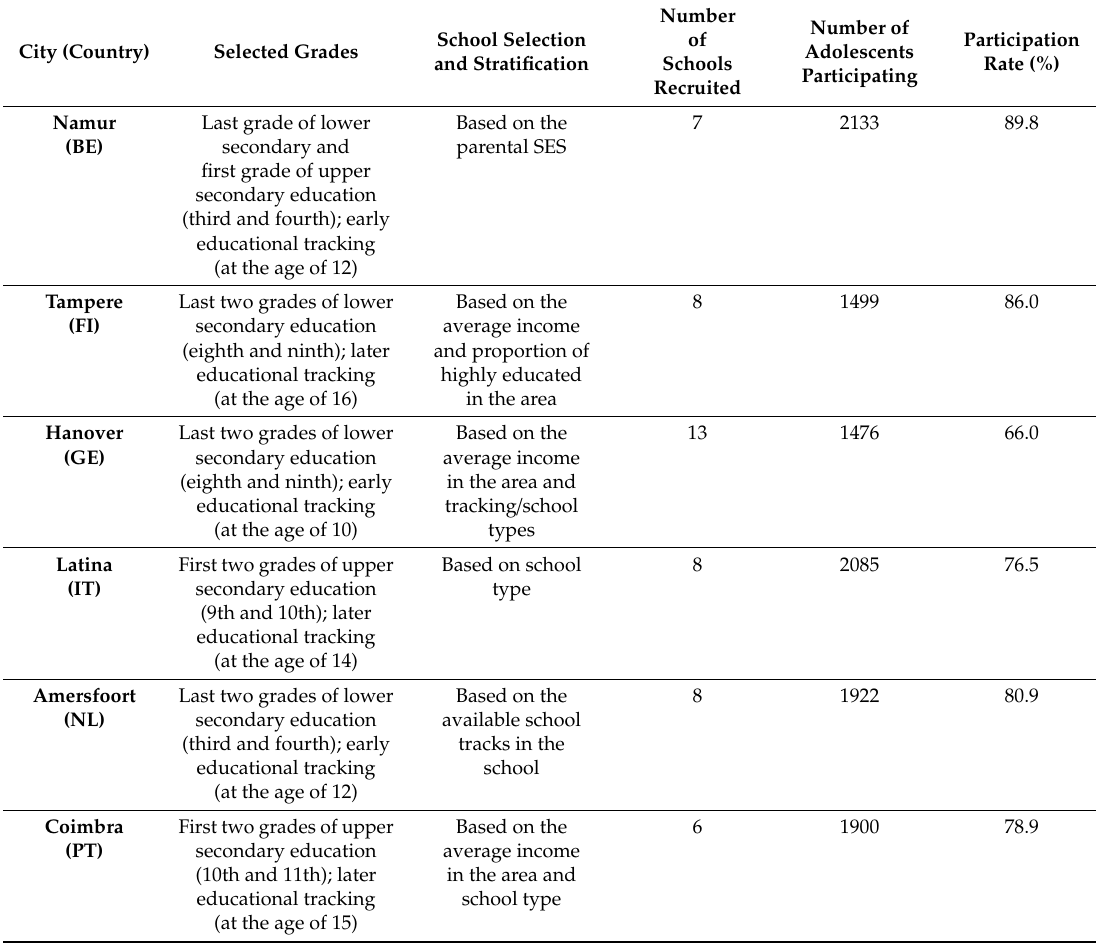
Table A2. Selected grades, school selection and stratification, number of schools recruited and adolescents participating, and participation rate per city in 2013